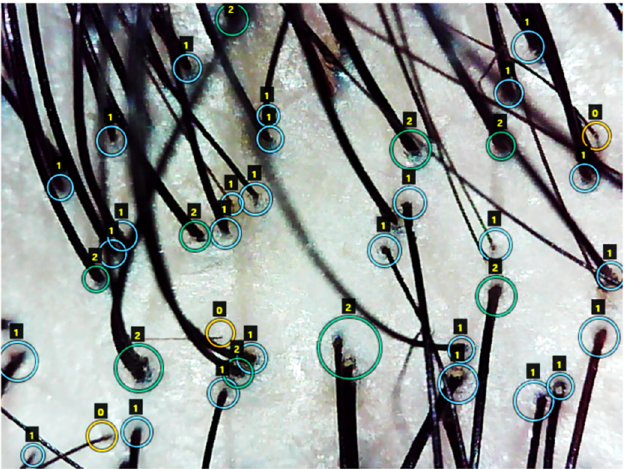
Figure 2. The label scheme of three classes using the VGG Image Annotation (VIA) tool; 0 and a yellow circle denotes “severe”, 1 and a blue circle denotes “normal”, and 2 and green circle denotes “healthy”.